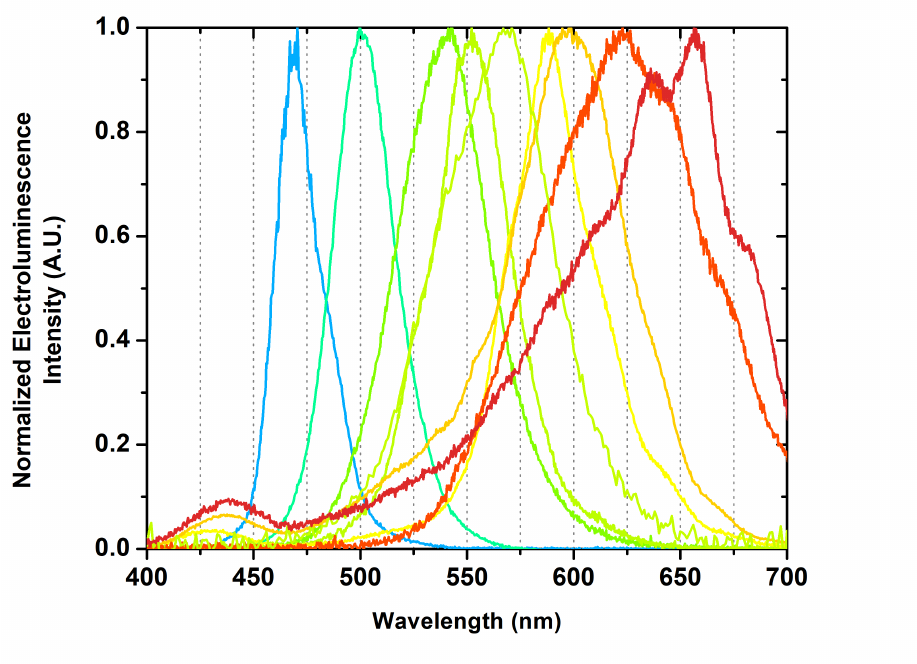
Figure 5. Normalized electroluminescence spectra from a large selection of grown and fabricated devices. All spectra were taken with 100 ms integration time and at 20 A/cm 2 with the exception of the 470 nm emitting device taken at 30 A/cm 2 to achieve adequate light